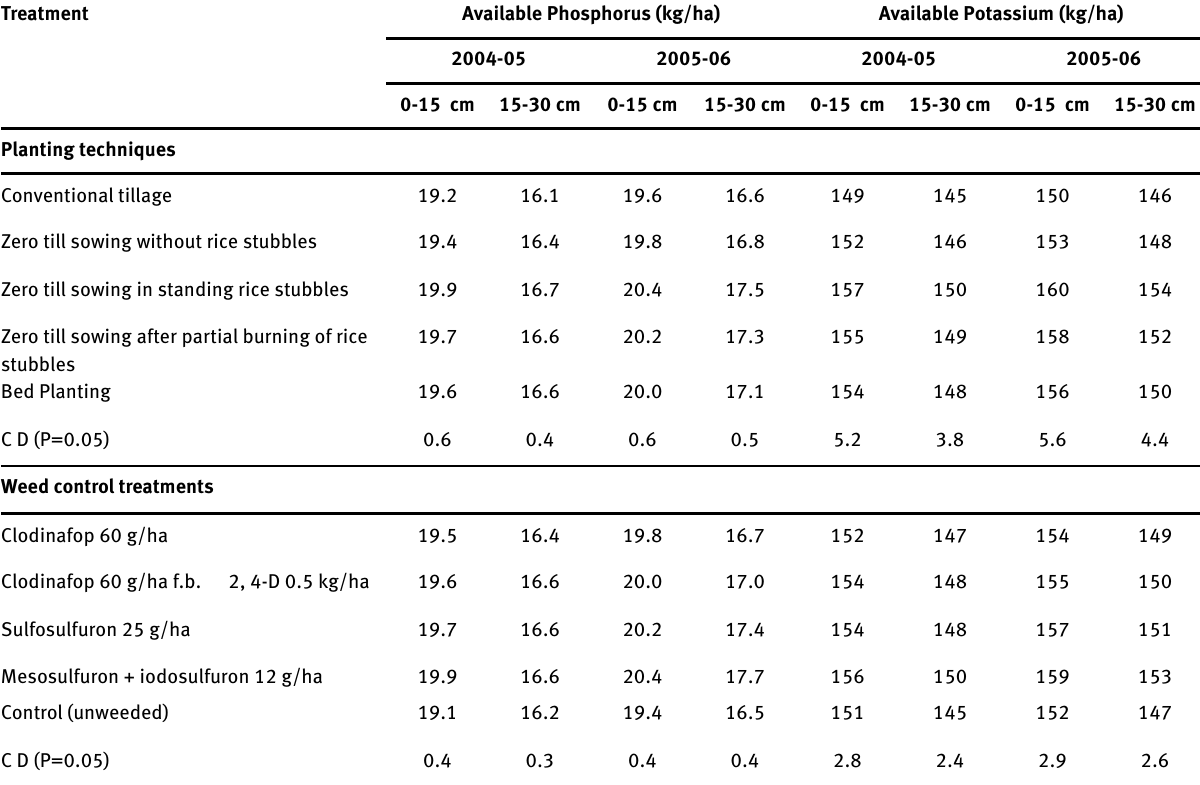
Table 3: Influence of planting techniques and weed control treatments available phosphorus and potassium in soil Treatment Available Phosphorus